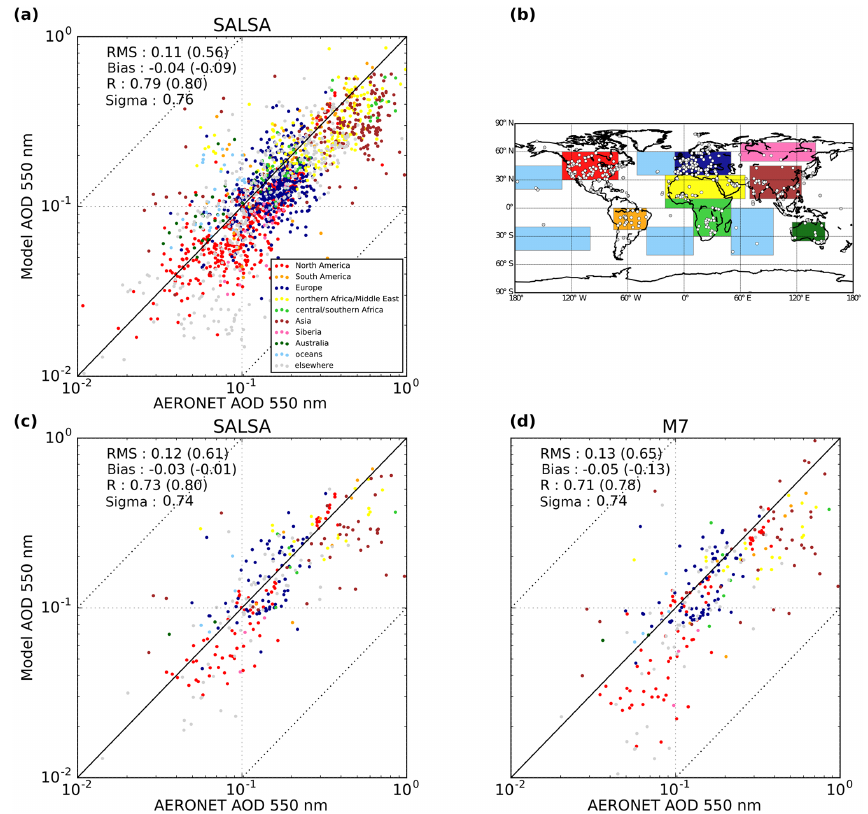
Figure 6. Scatter plots of yearly means of daily AERONET AOD values against yearly means of collocated simulated daily mean AODs. Panel (a) represents the comparison between AERONET and SALSA2.0 for the period 2003–2012. Colors in the scatter plots denote different regions shown in the map in panel (b) . Panel (c) shows the comparison between AERONET and SALSA2.0 for the year 2010, and (d) the comparison between AERONET and M7 for the year 2010. The given statistical values are the following: root mean square RMS (normalized RMS), absolute bias (normalized bias), correlation coefficient R ( R on log scale), and the ratio between simulated and observed standard deviation (sigma). Table 2. Yearly means of daily AOD values from AERONET, SALSA, and M7 and the corresponding correlation coefficient values for the